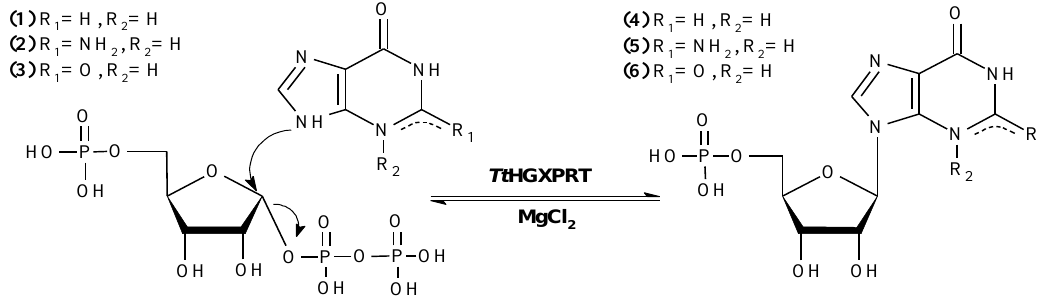
Figure 1. Enzymatic synthesis of nucleoside-5′-monophosphates (NMPs) catalyzed by Thermus themophilus HB8 ( Tt HGXPRT).